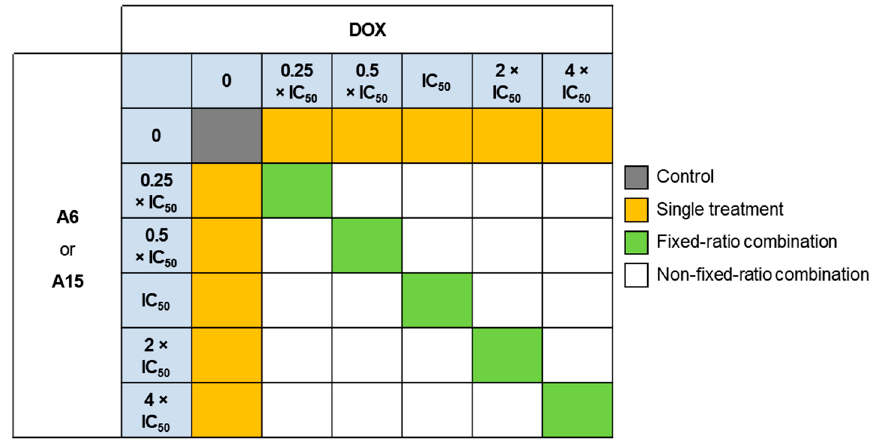
Figure 9. Concentrations of doxorubicin (DOX), A6 , A15 , and DOX combined with A6 or A15 at fixed ratios tested in MCF-7 and SK-BR-3 cells. Light blue boxes represent the fixed concentrations of each test compound; dark gray box represents the vehicle-treated control; yellow boxes represent the concentrations of A6 , A15 , or DOX for single treatment; green boxes represent the concentrations of fixed-ratio combinations; white boxes represent the concentrations of non-fixed-ratio combinations.